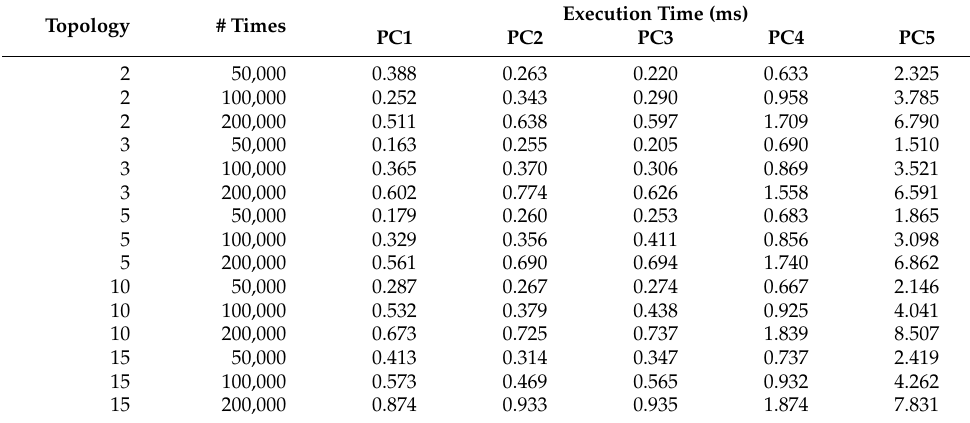
Table 6. Performance evaluation of series identical block.